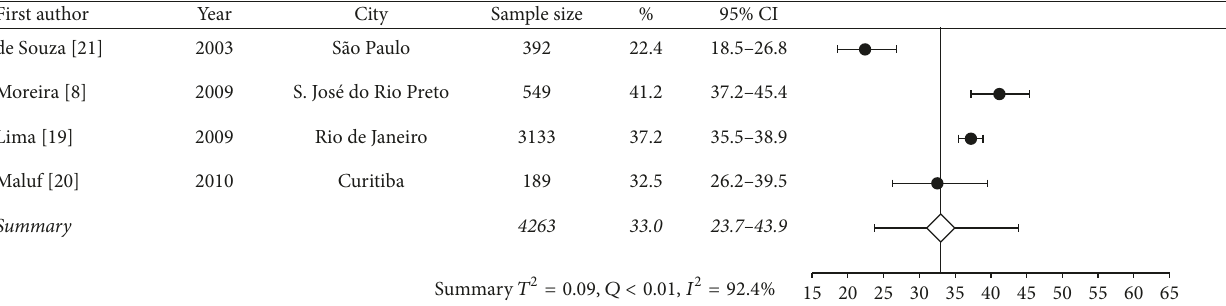
Figure 3: Meta-analysis of proportion of use of two blood pressure lowering